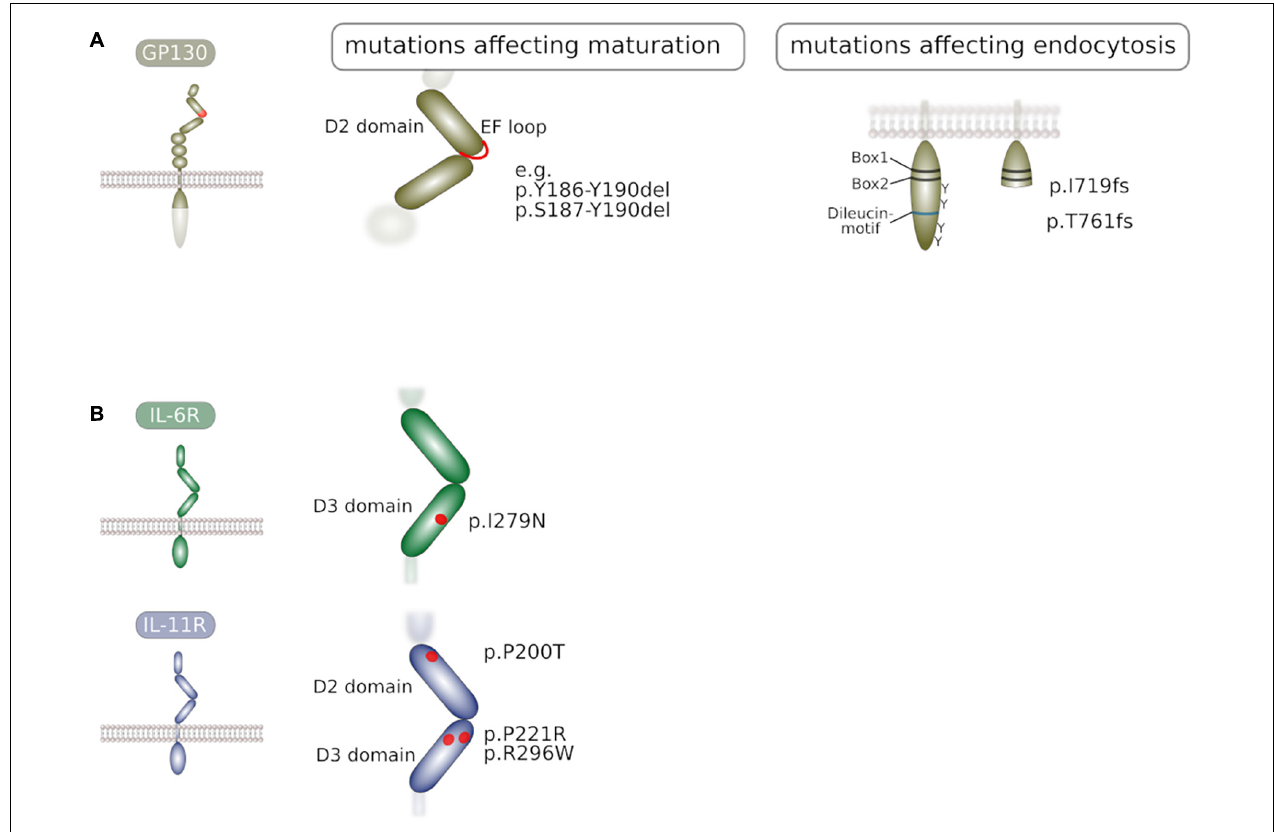
FIGURE 2 | (A) Mutations in GP130 that interfere with receptor maturation or receptor endocytosis. Activating deletion mutations in GP130 were found in inflammatory hepatocellular adenoma and impair GP130 maturation. Frameshift mutations that lead to truncated GP130 molecules devoid tyrosine residues and internalization motif are found in patients. (B) Mutations in the α receptor subunits IL-6R and IL-11R that impair receptor maturation to the plasma membrane. Point mutations in IL-6R are found in patients with a novel immunodeficiency syndrome. Point mutations in IL-11R are found in patients suffering from craniosynostosis. Prolonged residence of these mutants within the ER quality control is